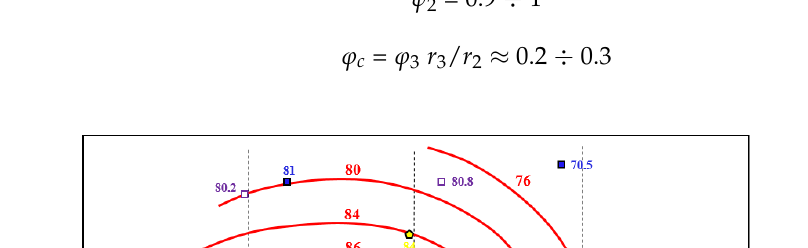
Figure 6. Chen and Baines